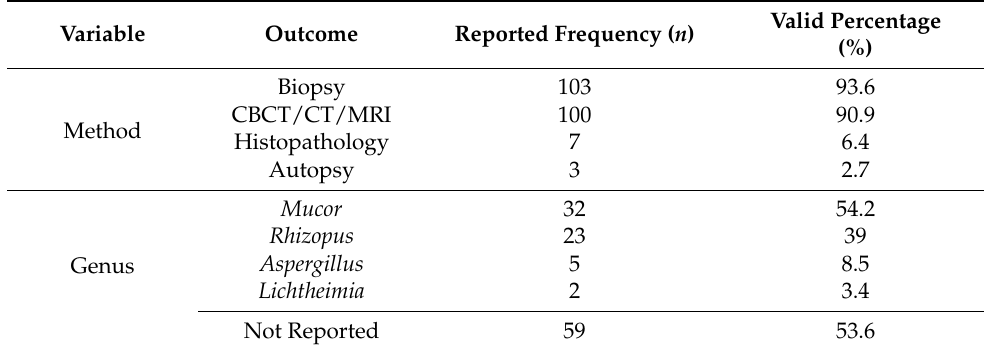
Table 5. Paraclinical Characteristics of COVID-19-associated Mucormycosis (CAM) Cases,